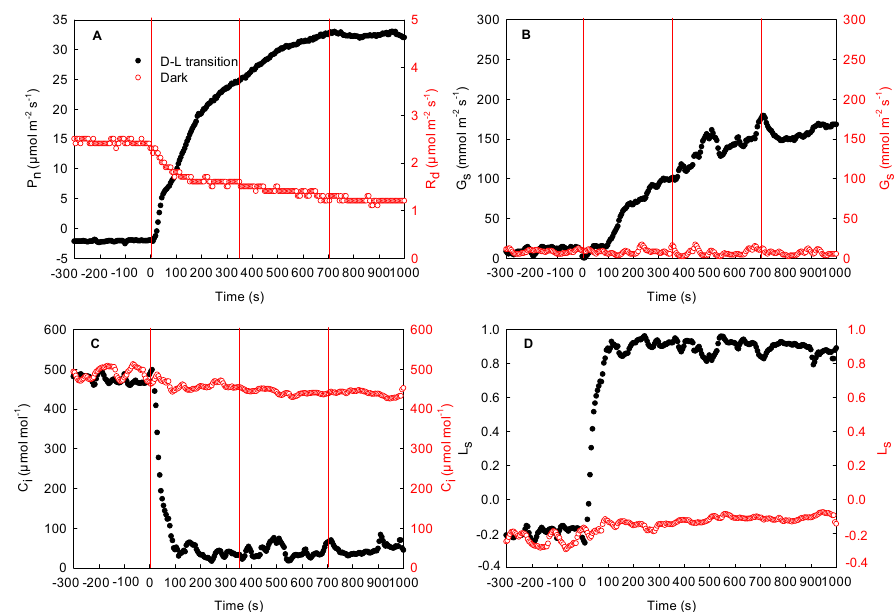
Figure 6. Effect of local illumination on the respiration rate of adjacent region in the same sorghum leaves. ( A ) photosynthetic induction under the dark–light transition in the local regions or respiration in darkness in the adjacent region; ( B ) stomatal conductance under the dark–light transition in the local regions or under the darkness in the adjacent region; ( C ) intercellular CO 2 concentration under the dark–light transition in the local regions or under the darkness in the adjacent region; ( D ) stomatal limitation under the dark–light transition in the local regions or in darkness in the adjacent region. C i , intercellular CO 2 concentration; D–L transition, dark–light transition; G s , stomatal conductance; L s , stomatal limitation; P n , photosynthetic rate; R d , respiration in darkness. 2.3. Effect of Local Illumination on the Photosynthetic Rate of the Adjacent Region in the Same Leaves